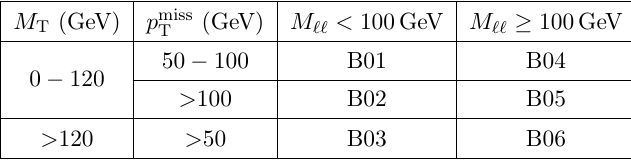
Table 3 . Search regions corresponding to category B, events with three e or (cid:22) that do not form an opposite-sign same-(cid:13)avor (OSSF)